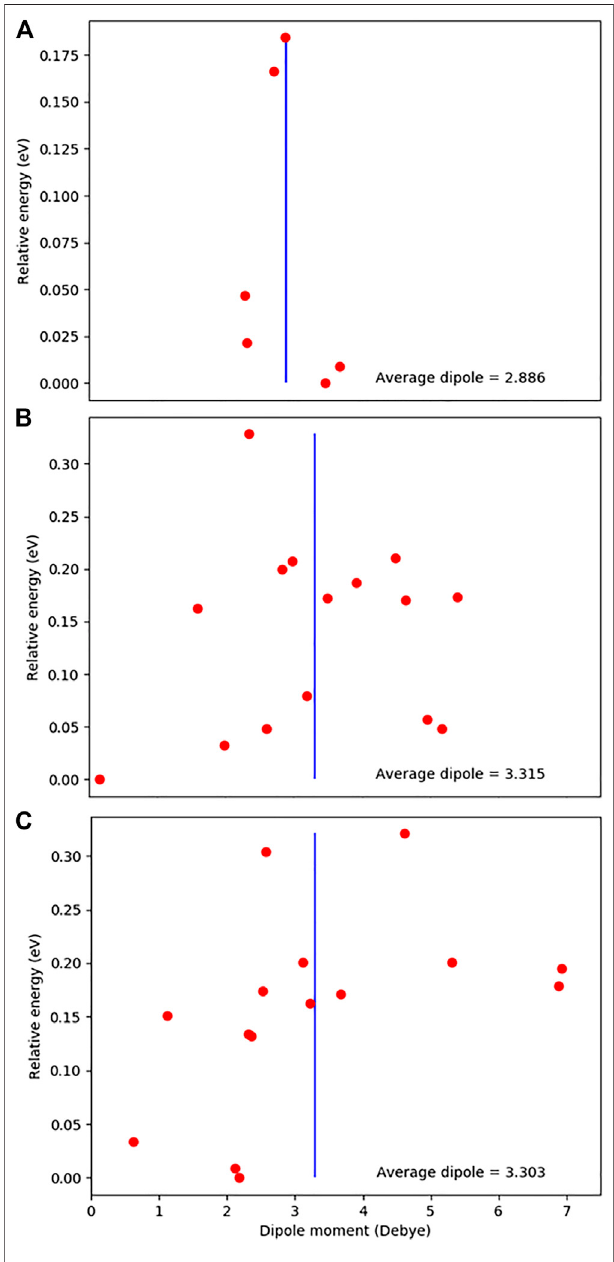
FIGURE 5 | Plot of relative energy vs. dipole moment for molecularly hydrated (MgSiO 3 ) 6 nanosilicates based on the low dipole bare nanosilicate ( Figure 1A ) for (A) one, (B) two, and (C) three water molecules. The vertical blue line denotes the average dipole moment of each set. In each plot, data from approximately 100 isomers are